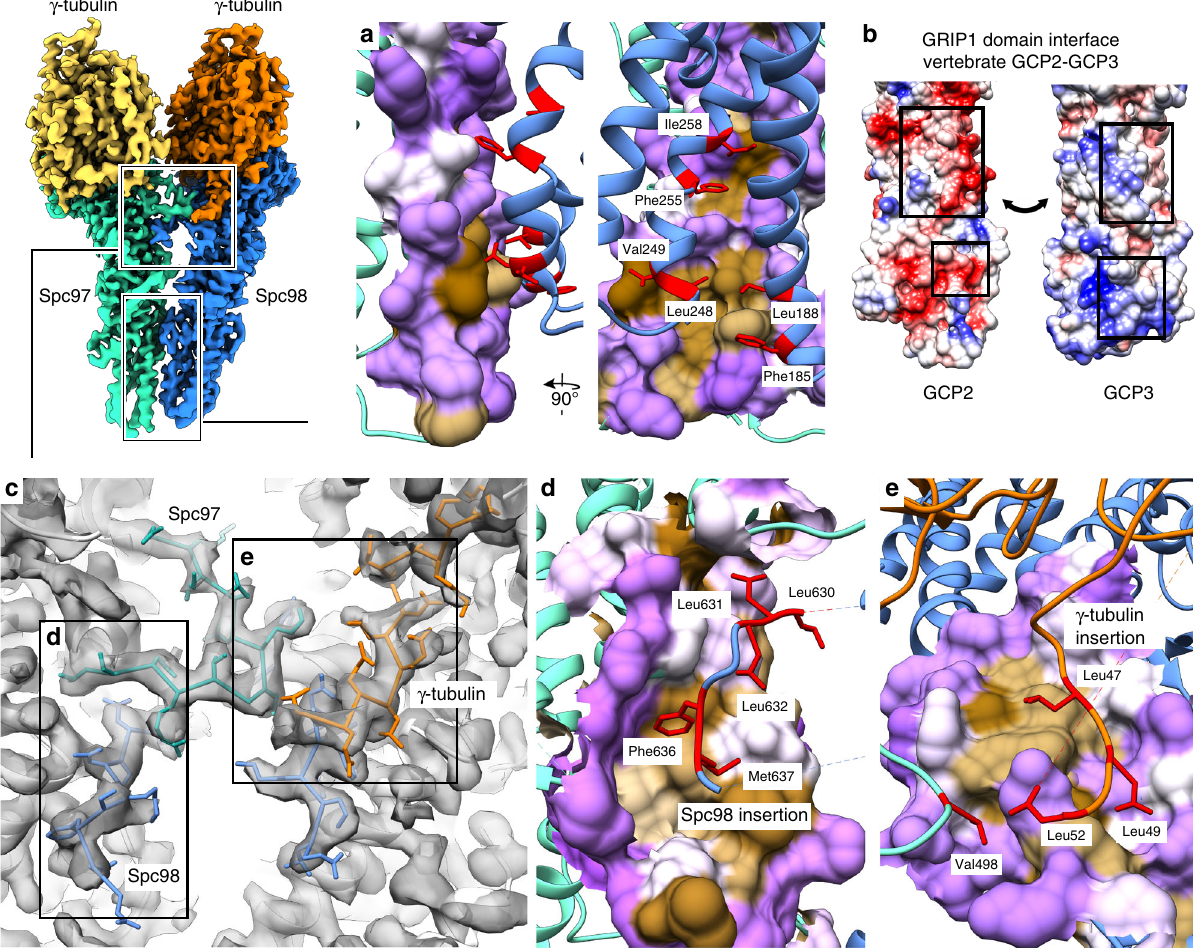
Fig. 2 Protein insertions form an extended interface between γ -TuSC spokes. a Zoom on the interface between the Spc97 and Spc98 GRIP1 domains as indicated in the overview. The Spc97 interface is represented as surface, color-coded according to hydrophobicity (brown: hydrophobic; purple: hydrophilic). Spc98 is represented as ribbon, with amino acid side chains mediating the hydrophobic interaction shown and depicted in red. b Interface between the human GCP2 (left) and GCP3 (left) GRIP1 domains. Complementary charged patches on the two surfaces mediate the interaction. Surface representation of the atomic model, colored according to charge (red: negative, blue: positive, and white: no charge). c Zoom on the fungi-speci fi c extended interface between the γ -TuSC spokes as indicated in the overview. The atomic model (white) is shown superposed to the cryo-EM density (transparent). Fungi-speci fi c loops mediating the interaction are colored as in Fig. 1a. d Zoom on the interface between Spc97 and the Spc98 insertion, as indicated in c . Representation as in a . e Zoom on the interface between Spc98 and the γ -tubulin insertion, as indicated in c . Representation as in a , but with Spc98 in surface